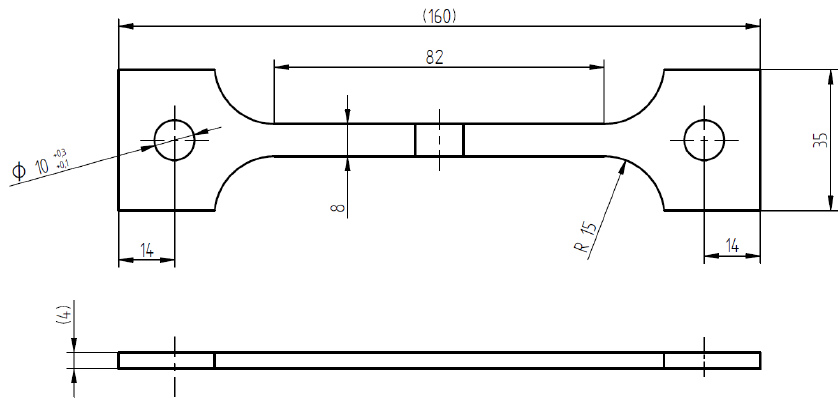
Figure 2. CL and SSR specimen: the weld is in the center of the gouge length, the thermomechanical affected zone/heat ‐ affected zone (TMAZ/HAZ) extension is 40 mm for each side.